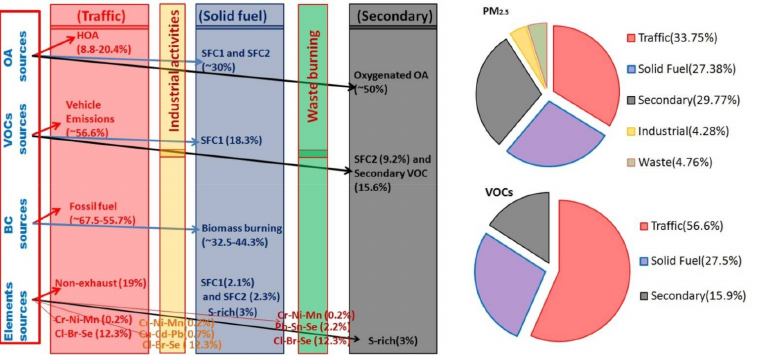
Figure 6. Fractional contributions of the major five sources of different types of PM 2.5 and VOCs in Delhi during late